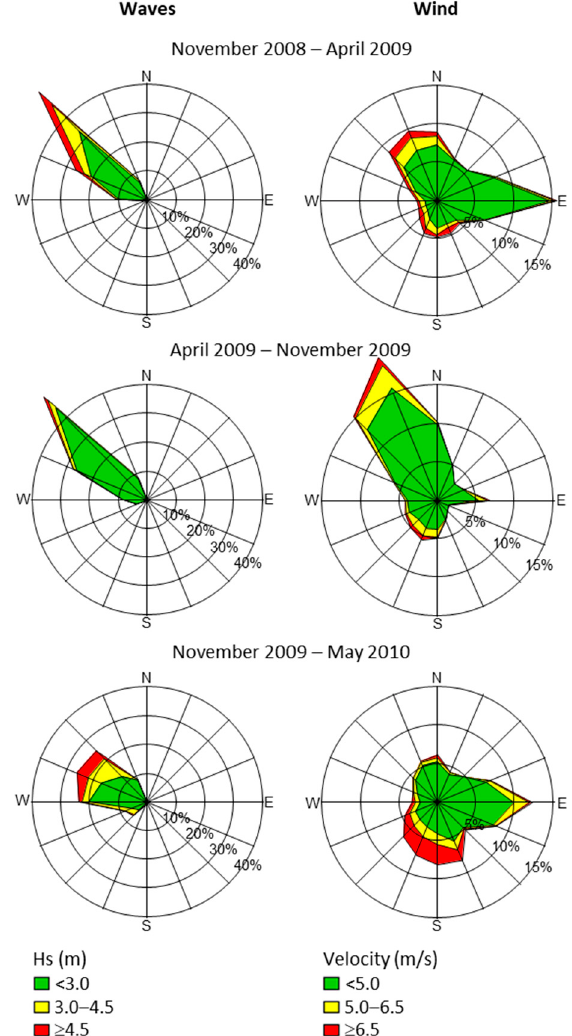
Figure 5. Distribution of 3-hourly wave directions for three significant-wave-height classes ( left plots ) and hourly wind directions for three velocity classes ( right plots ) for the 3 seasons monitored (from top to bottom: winter, summer, winter).